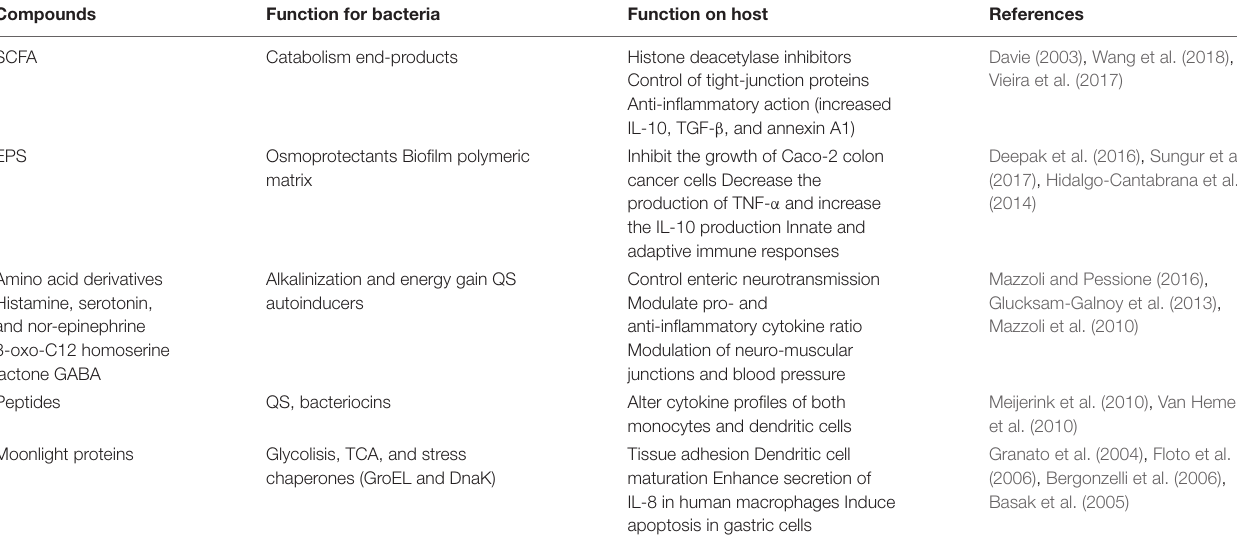
TABLE 1 | Multitasking bacterial-derived compounds and their different roles in bacteria and host. Compounds Function for